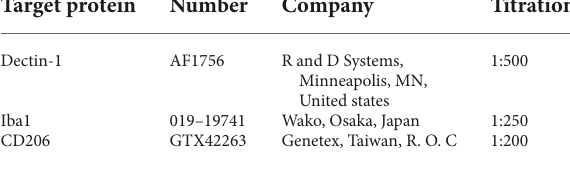
TABLE 1 List of primary